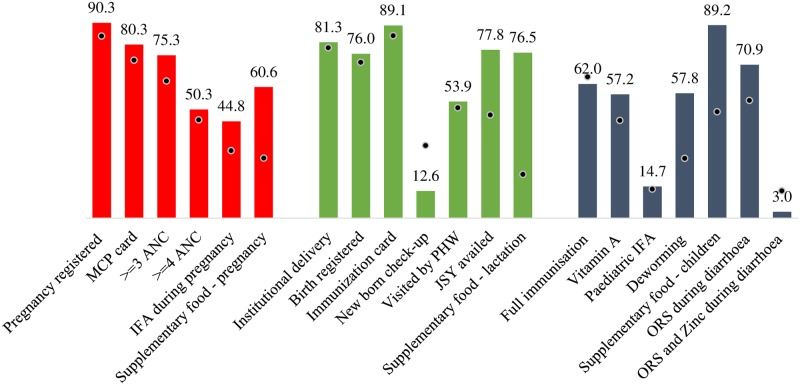
Coverage of nutrition interventions across the continuum of care in Odisha.The data represented here is from the Rapid Survey of Children (RSOC 2014). Columns represent the coverage of the indicators in Odisha in 2014. Dots represent the national average of the indicators in 2014. Coverage is reported in percentages. Left-most bars in red denote interventions delivered during pregnancy; central bars in green denote those delivered during the first 6 months post-partum; right-most bars in blue are those delivered from 6 months to 5 years of age. MCP = Mother child protection; ANC = Antenatal care visit, IFA = Iron-folic acid, PHW = Public/primary health worker; JSY = Janani Suraksha Yojana (A cash transfer to promote institutional delivery); ORS = Oral dehydration salts.